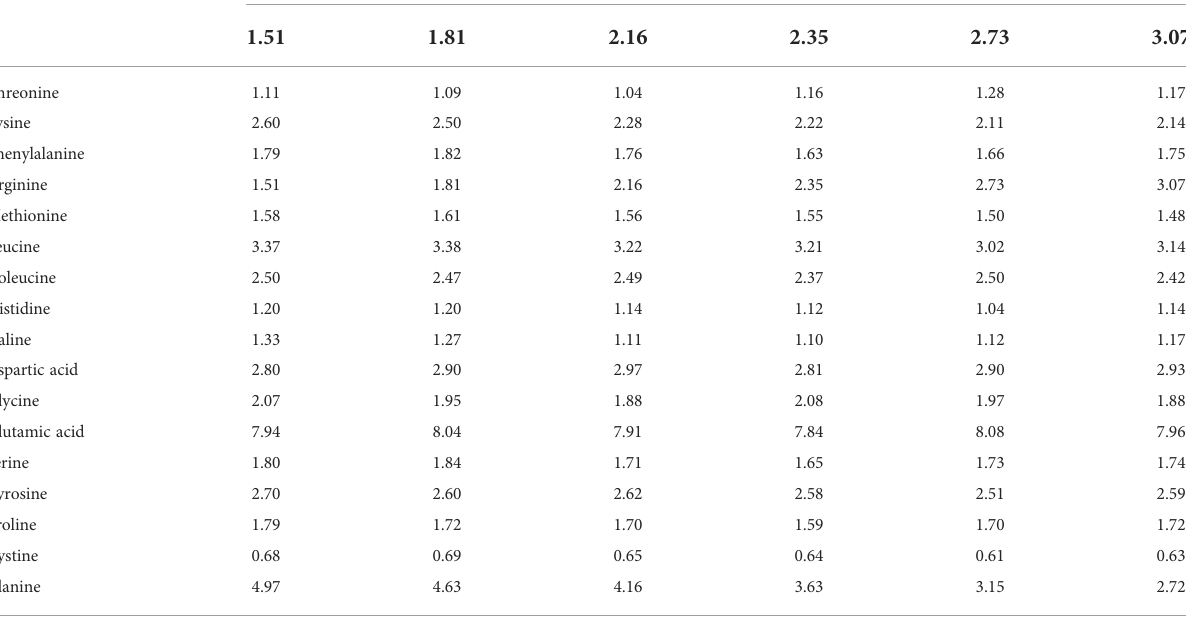
TABLE 2 Amino acids composition of the experimental diets. Amino acids